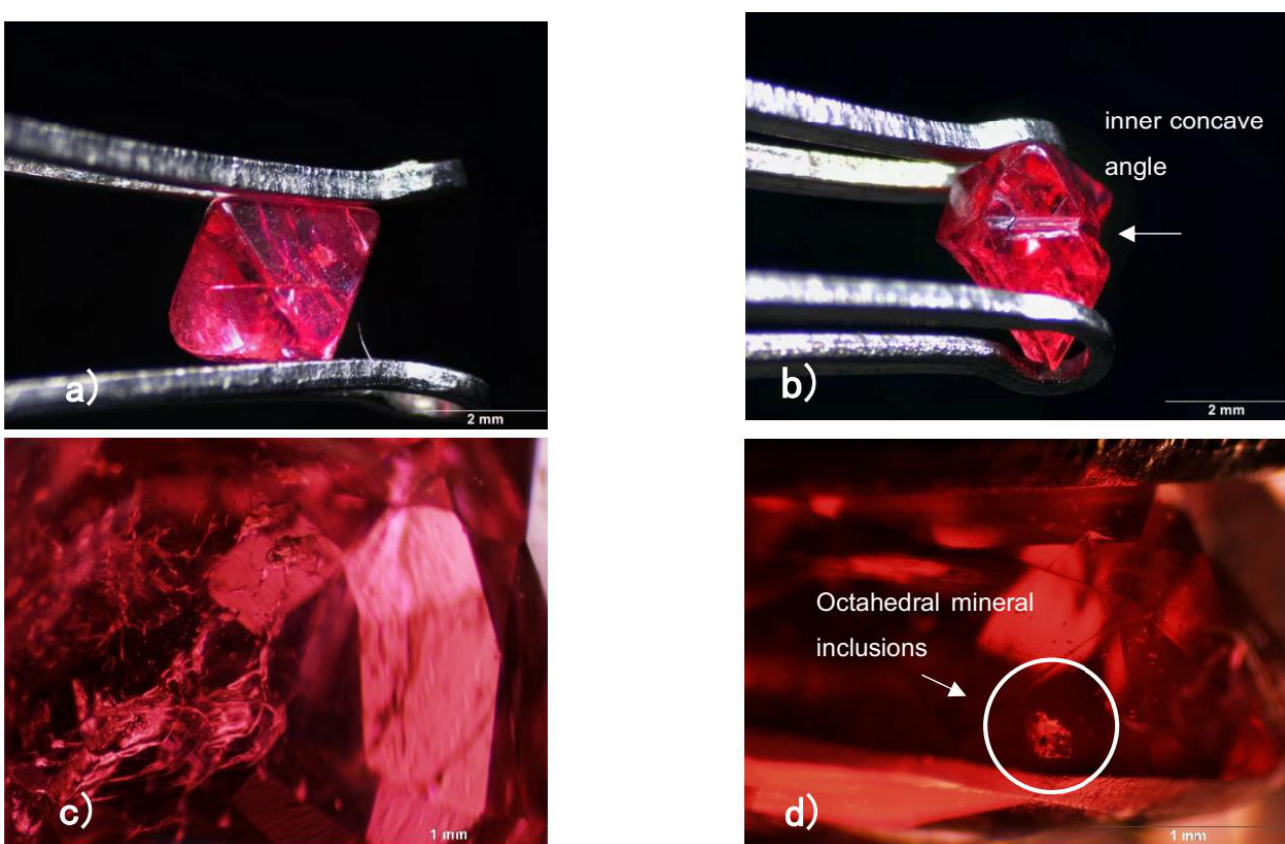
Figure 3. ( a ) Fine transparent octahedral crystals (MS-13); ( b ) Spinel twin with inner concave angle. Goose row-like distribution of fine octahedral spinel inclusions, and external brown solid inclusions (MS-7); ( c ) Massive healing fractures containing liquid inclusions (MS-2); ( d ) Octahedral mineral inclusions in spinel with solid black-brown inclusions (MS-1).